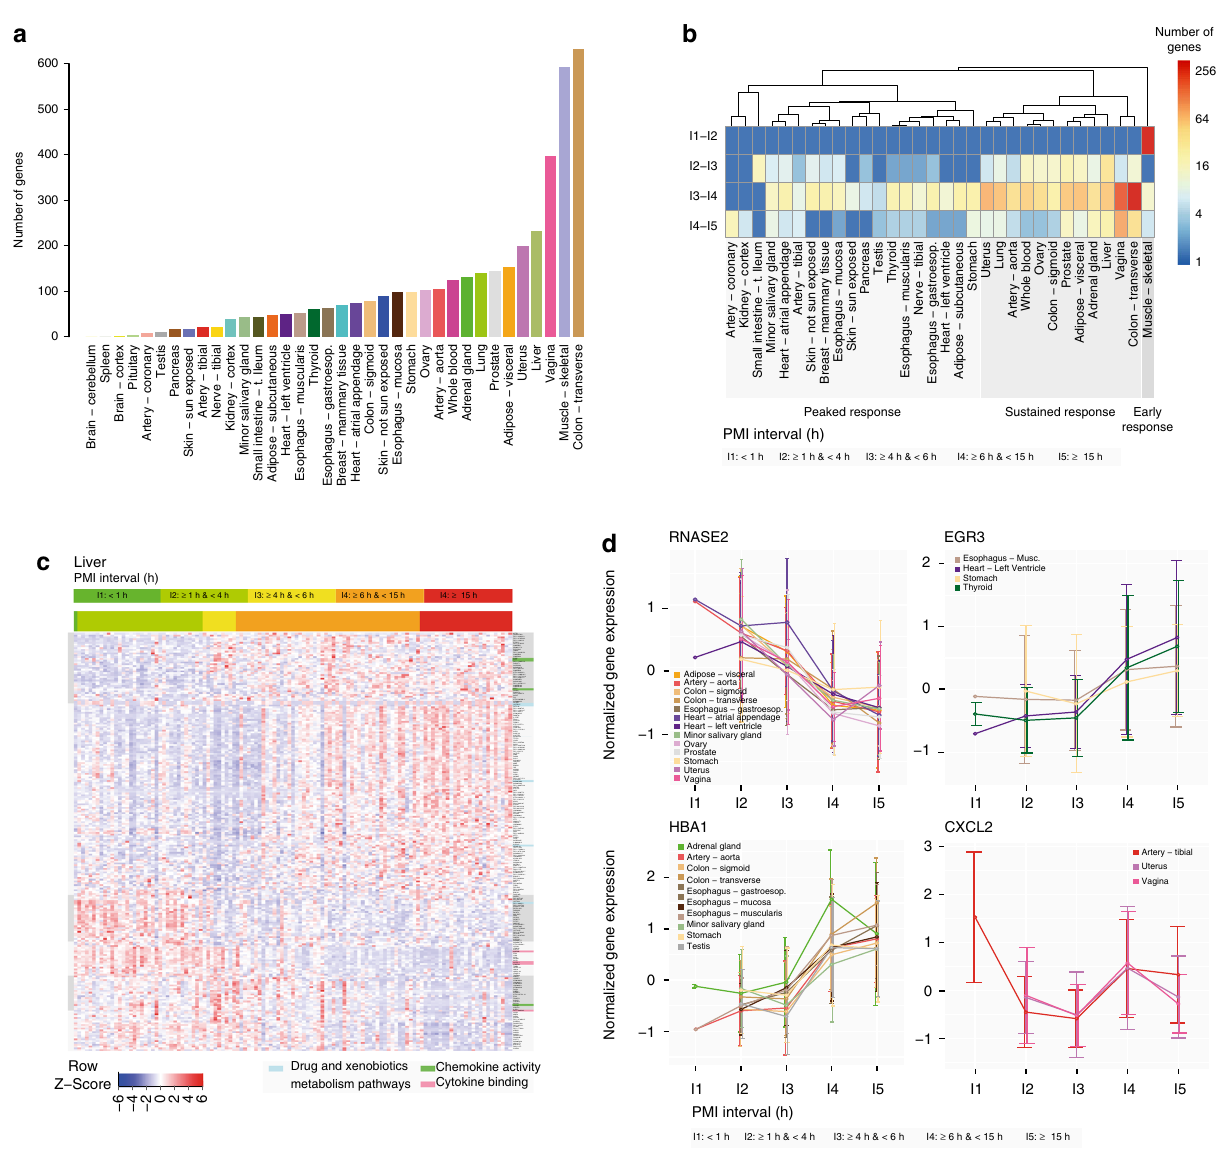
Fig. 2 Effect of PMI on gene expression. a Distribution of the number of genes with signi fi cant temporal changes per tissue between at least two time intervals. Brain and pituitary have longer PMIs, only within last two time intervals, thus less interval ranges to detect signi fi cant changes. b Heatmap with the number of genes with signi fi cant changes detected between two consecutive time intervals. c Heatmap with normalized expression values for genes with changes in liver. The top bar is the color code for the PMI interval of each sample, the right bar list genes involved in the various functions and pathways. On the side we highlight sub-clusters with different patterns of temporal expression. d Example of four genes with different temporal patterns. RNASE2 is a non-secretory ribonuclease involved in several functions; HBA1 is alpha hemoglobin involved in oxygen transport; EGR3 is a transcriptional regulator involved in early growth response; CXCL2 is a chemokine gene that encodes secreted proteins involved in immune and in fl ammatory